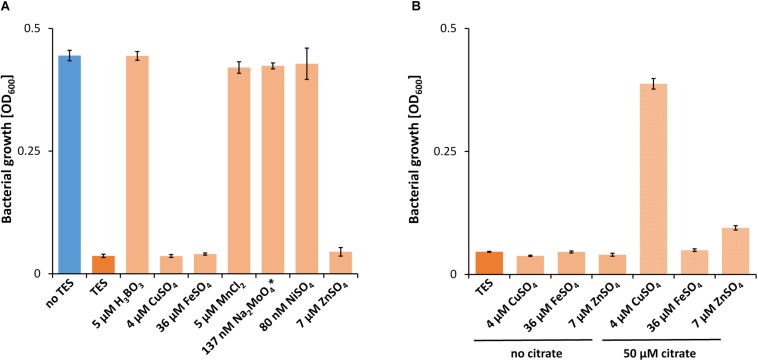
(A) Growth of ΔpedE in 1 mL liquid M9 medium in 96-well deep-well plates on 5 mM 2-phenylethanol and 10 nM La3+ in the presence of TES or individual components thereof. (B) Growth of ΔpedE as described in (A) with and without the additional supplementation of 50 μM Na3-citrate. OD600 was determined upon 48 h of incubation at 30°C and 350 rpm. Data are presented as the mean values of biological triplicates and error bars represent the corresponding standard deviations. ∗Tested condition with 137 nM NaMoO4 also contains 5 μM H3BO3 and 84 nM NiSO4.